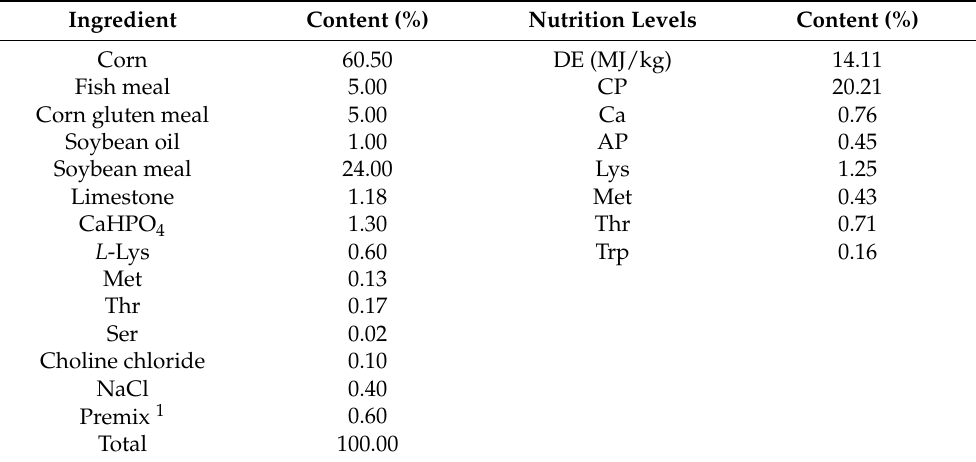
Table 1. Composition and nutrient levels of basal diets (air-dry basis).